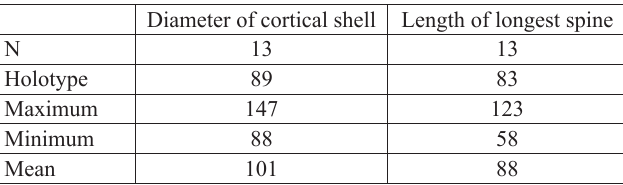
Table 3. Dimensions (in μ m) of Loupanus pliensbachicus Cifer sp. nov. N, number of specimens